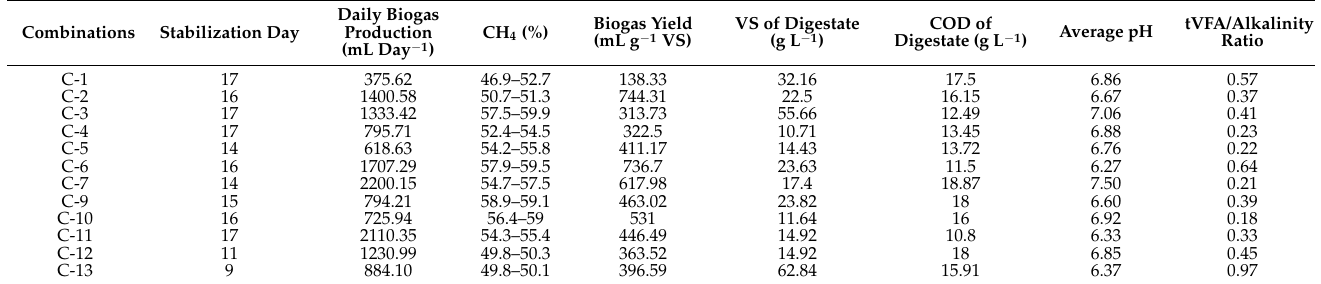
Table 3. Follow-up parameters of the co-digested assays in a semi-continuous